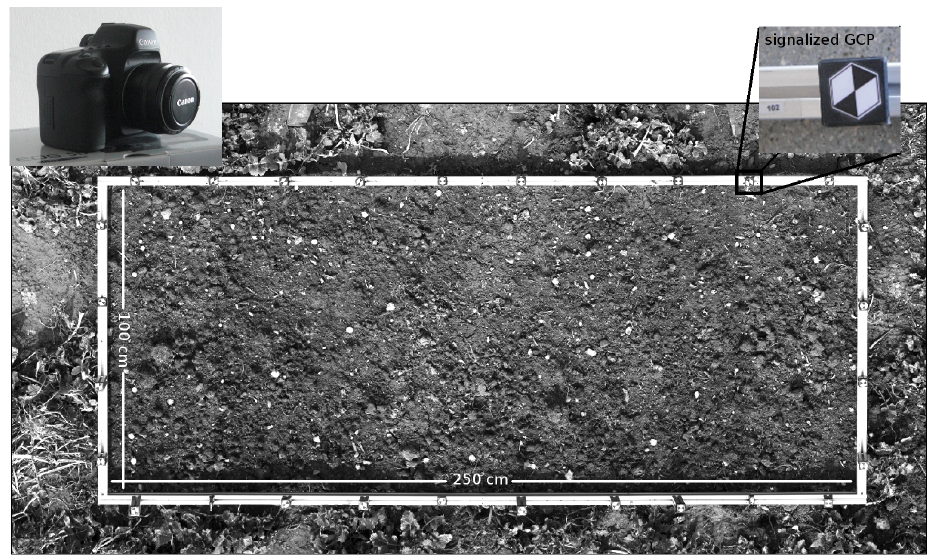
Figure 1. Reference frame for relative orientation of the images acquired for DSM generation and detailed view of a GCP.